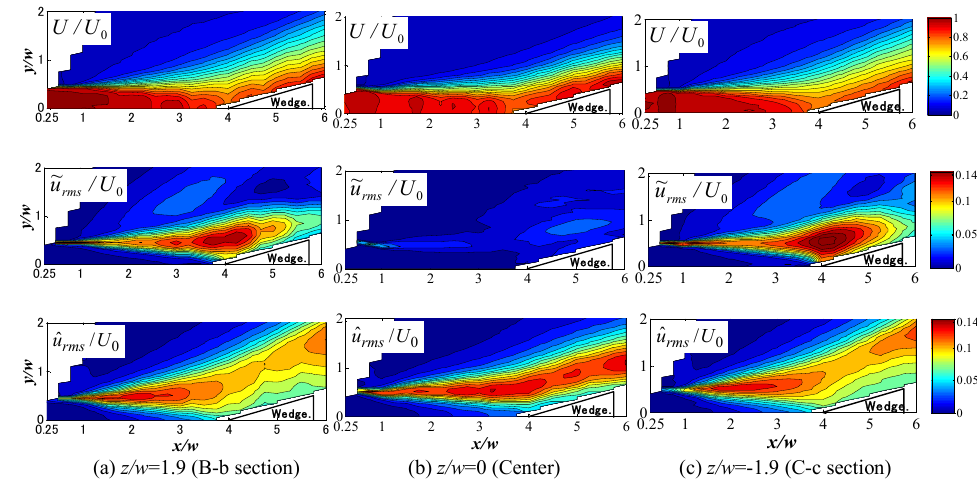
Fig.7 Contour maps of U / U 0